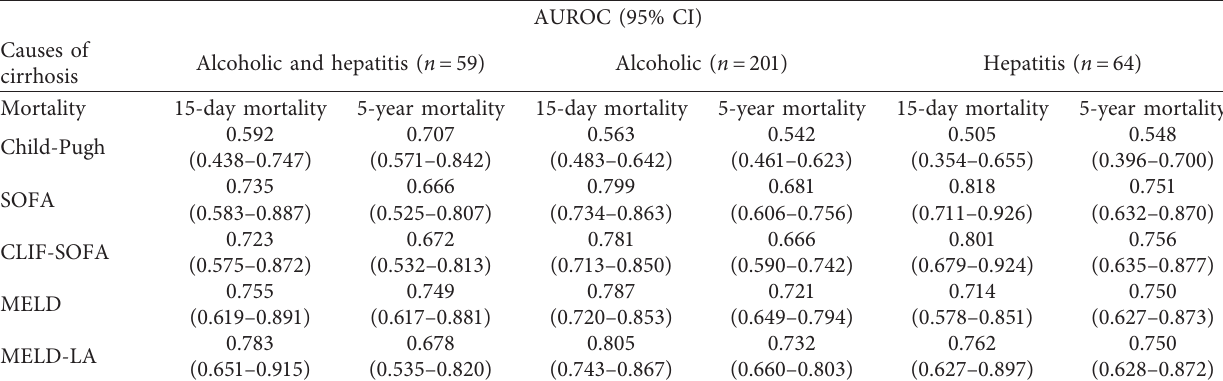
Table 3: Model discrimination for mortality, stratified by causes of